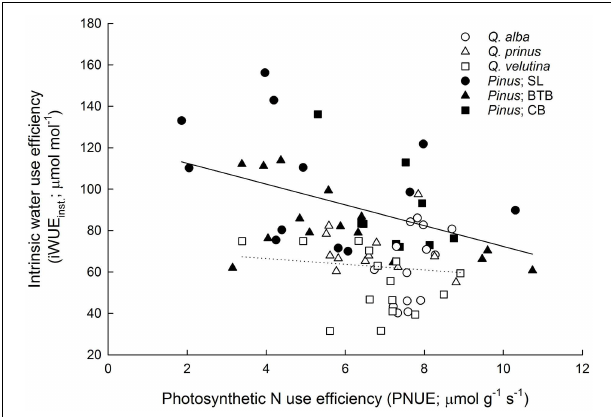
FIGURE 5 | Photosynthetic nitrogen use efficiency (PNUE; µ mol CO 2 g − 1 N s − 1 ) vs. instantaneous intrinsic water use efficiency (iWUE inst . ; µ mol CO 2 mol − 1 H 2 O) for oaks and pines. Pines exhibited a significant negative relationship (solid line; y = − 5 . 02x + 122 . 5 ; r 2 = 0 . 21 ) between PNUE and iWUE inst . , while the slope of the relationship for oak was not statistically different from zero (dotted line; P = 0 .54). Points represent average across A / C i and light response curves for each individual during each measurement period. Solid lines represent significant relationships (slope P < 0 . 05 ); dotted lines represent non-significant relationships (slope P > 0 . 05 ).